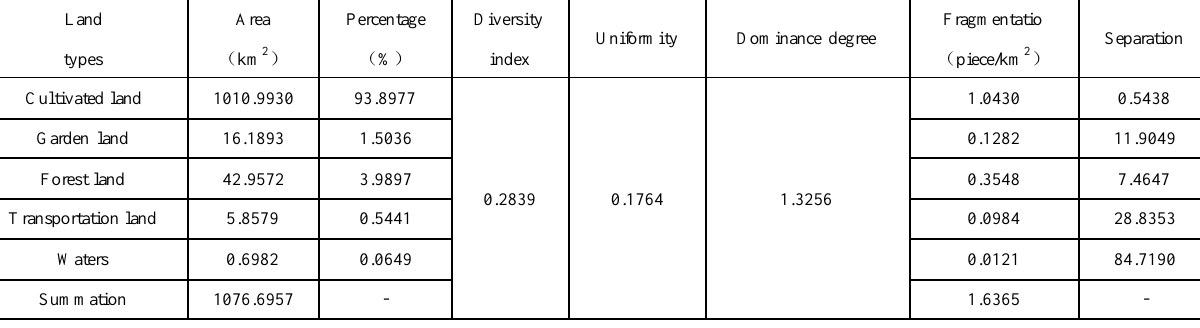
Table 2. Quantitative characteristics of land-use